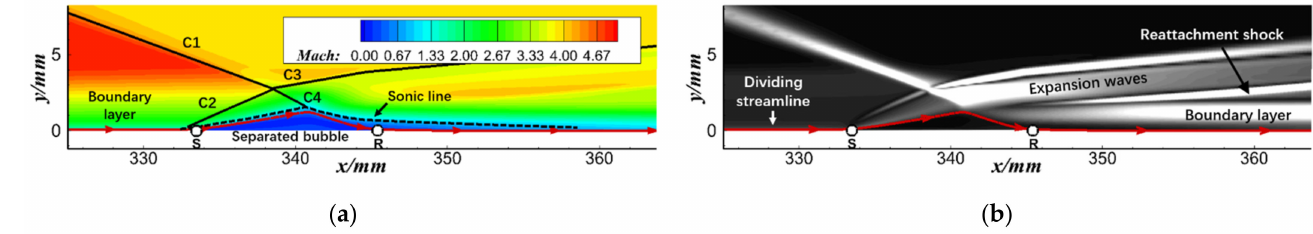
Figure 4. Flow structure on the symmetry plane for θ = 10 ◦ case. ( a ) Mach number contour; ( b ) density gradient